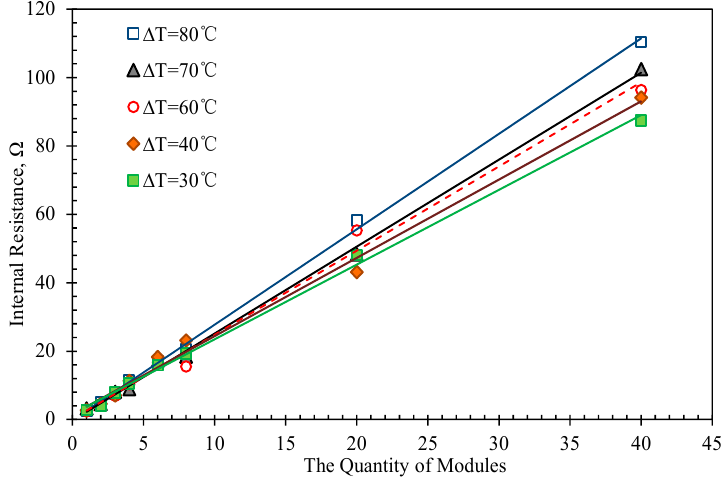
Figure 3. Relationship between total internal resistance and quantity of modules in series.